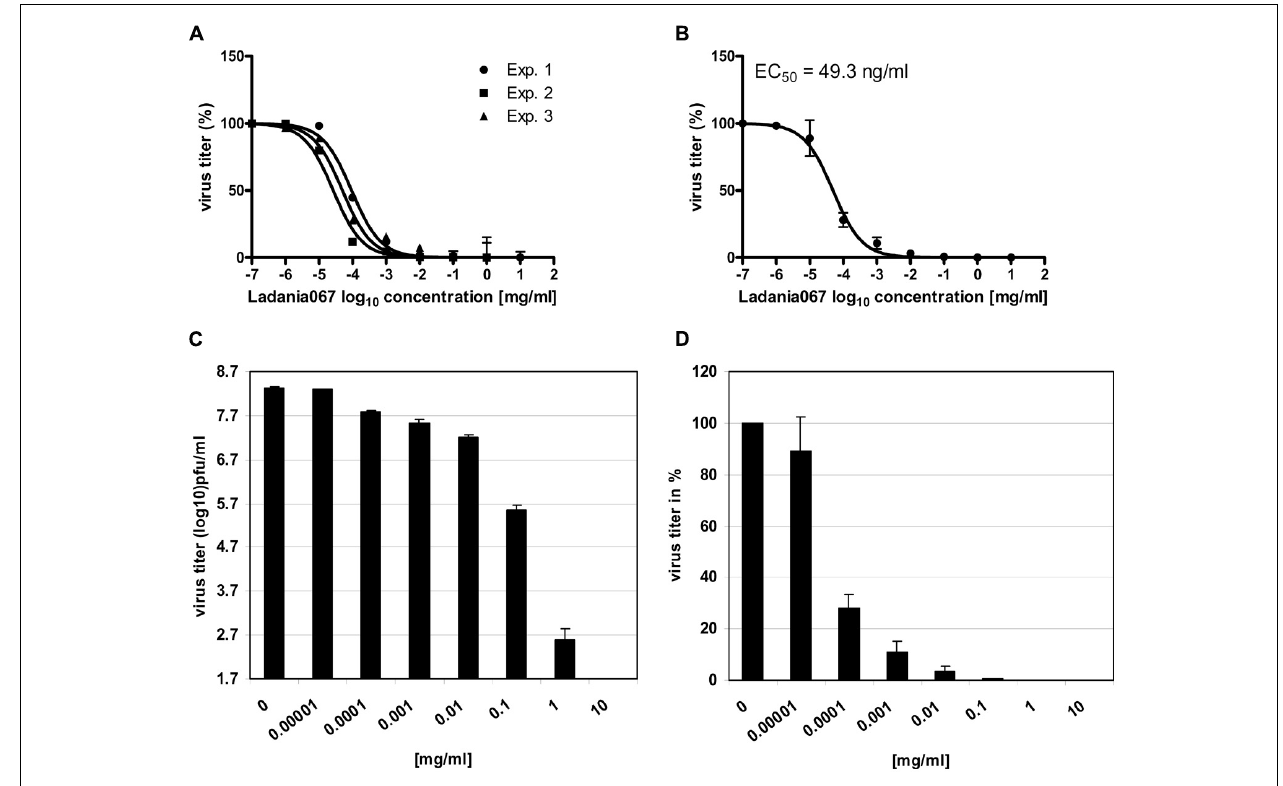
titer was determined by plaque assay. (A) Results of three independent experiments, (B) mean of three independent experiments, calculated by GraphPad Prism software. ( C : pfu/ml) and ( D : %) shows results in bar charts. For calculation, each experiment was performed three times independently with each comprising